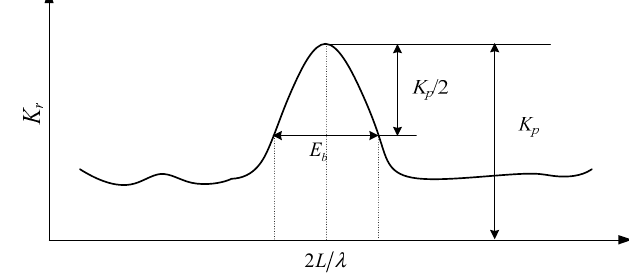
Figure 5. Definition of the characteristics of Bragg reflection.